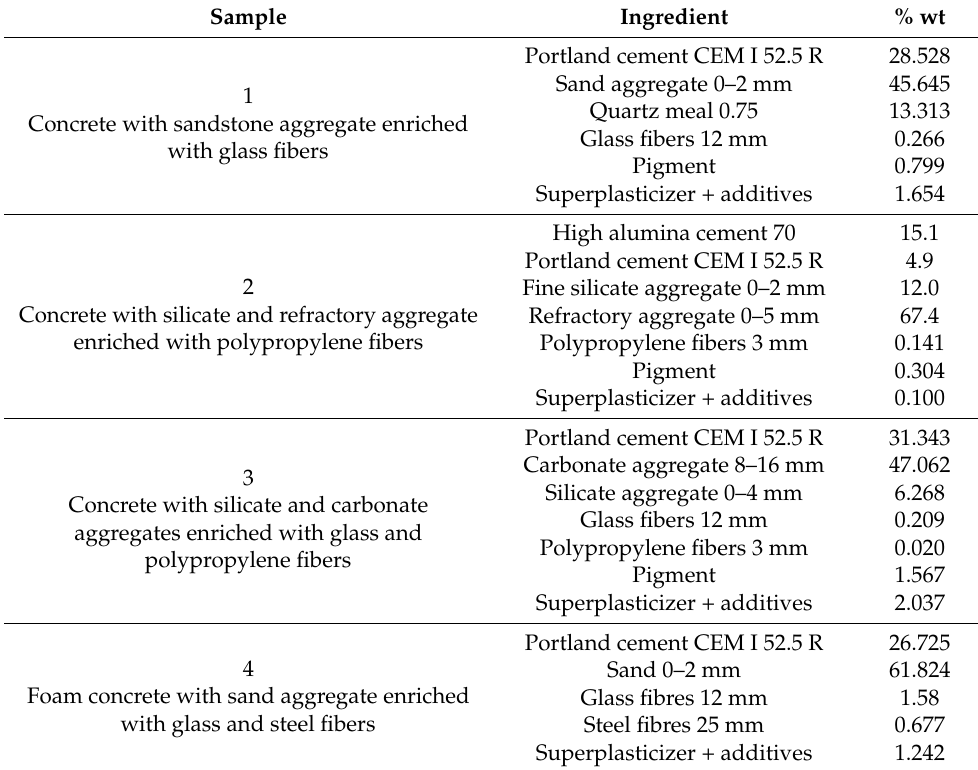
Table 1. Concrete mix compositions used in